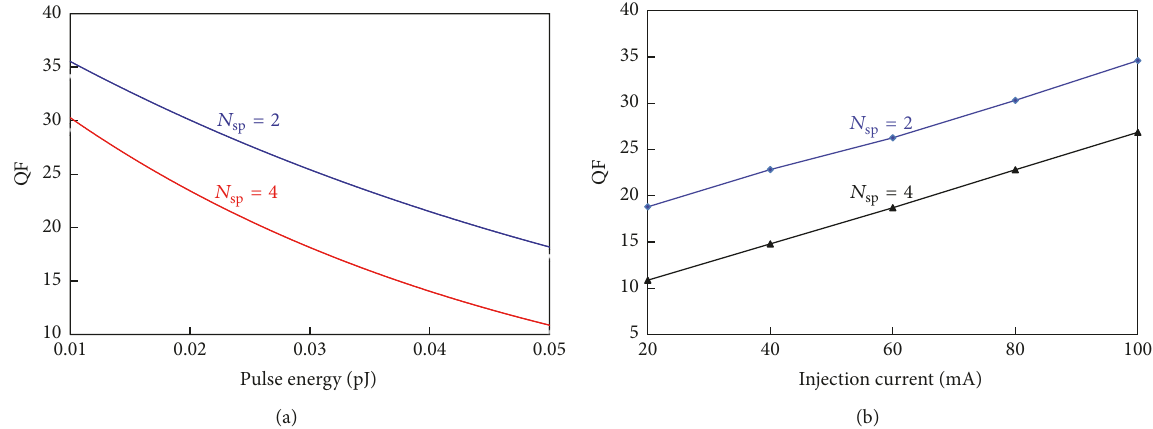
Figure 3: QF versus (a) pulse energy and (b) SOA’s injection current for AND operation at 𝑁